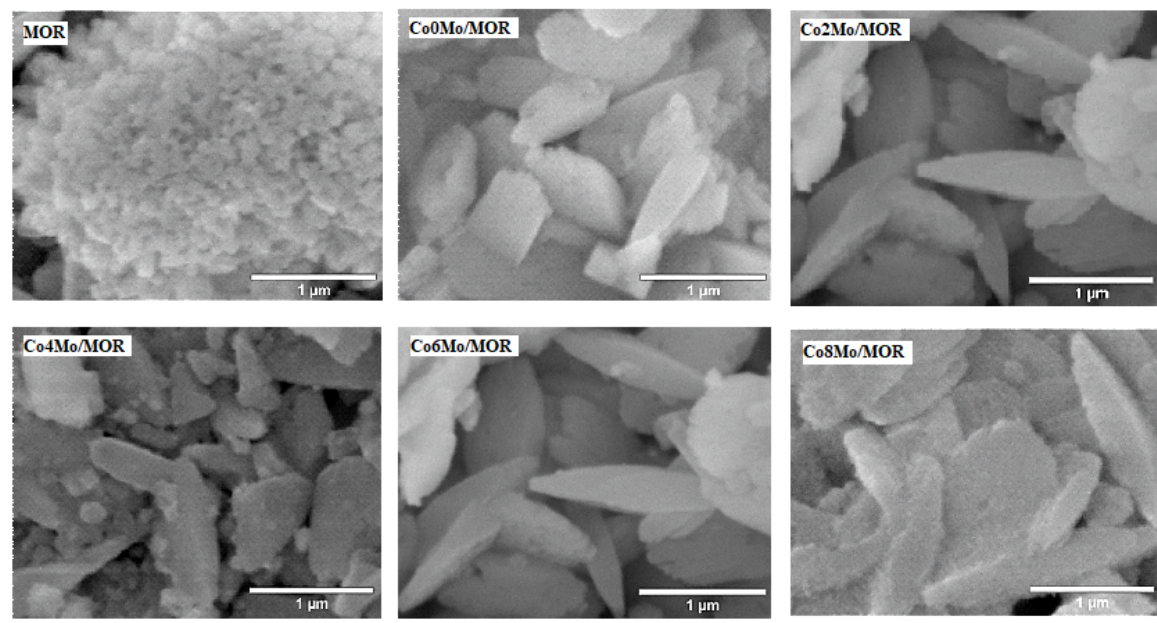
Figure 7: Profile of the adsorption isotherm of MOR and CoMo/MOR catalysts.